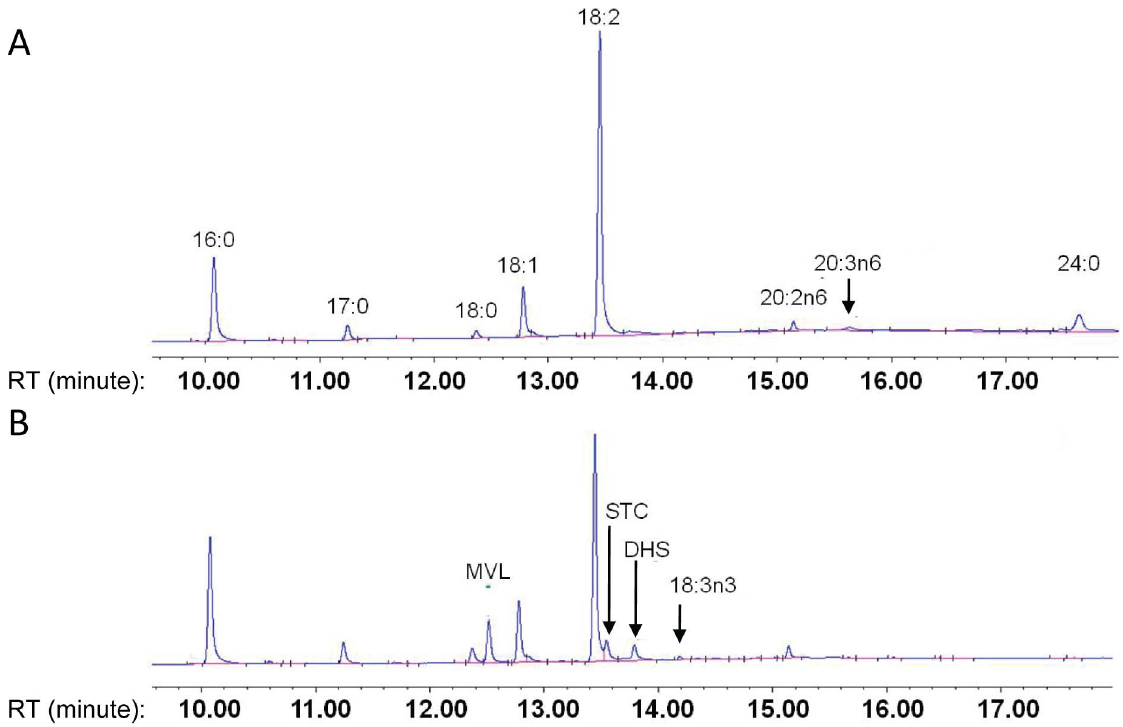
Figure 8. GC analysis of FAMEs extracted from developing embryo. (A) 30 DAP cotyledon (B) 30 DAP embryo axis.